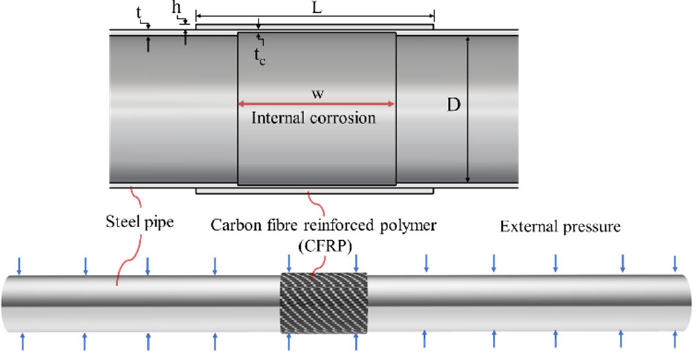
Figure 2. Schematic diagram of internal defects and repaired pipeline.